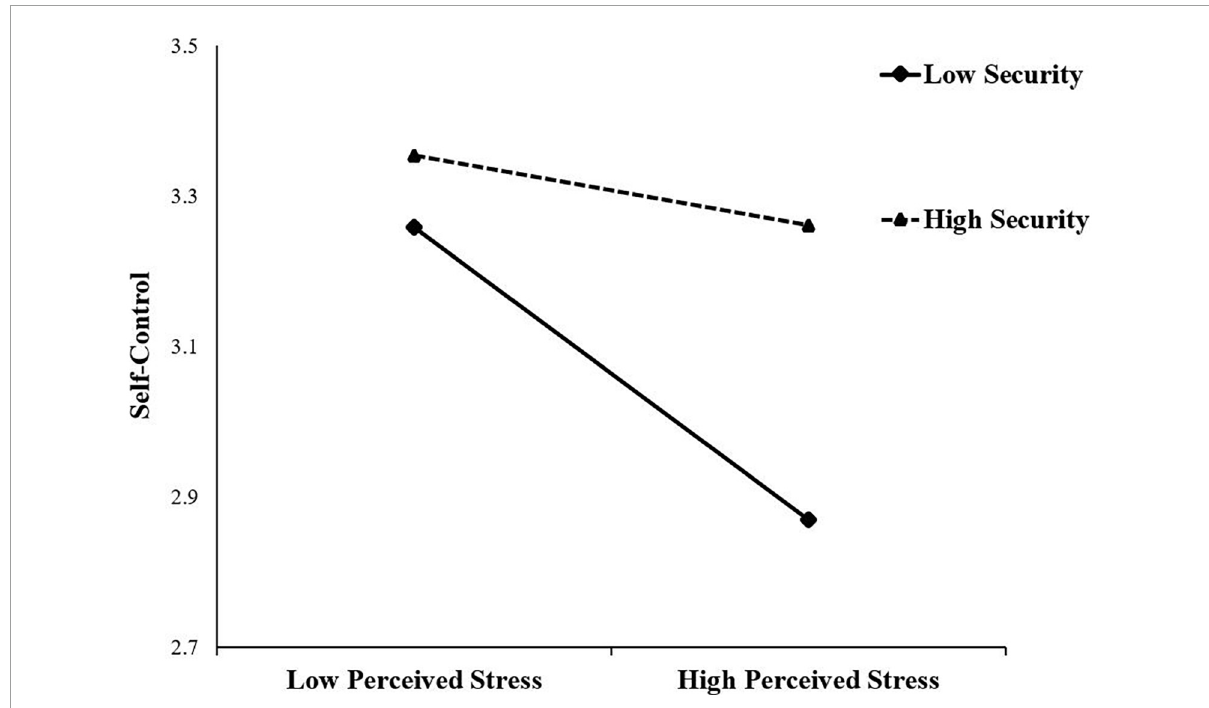
FIGURE2 Security moderated the association between perceived stress and self-control.